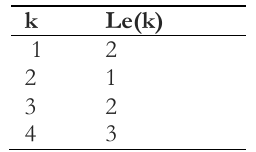
Table 4. Level of skills for health workers.